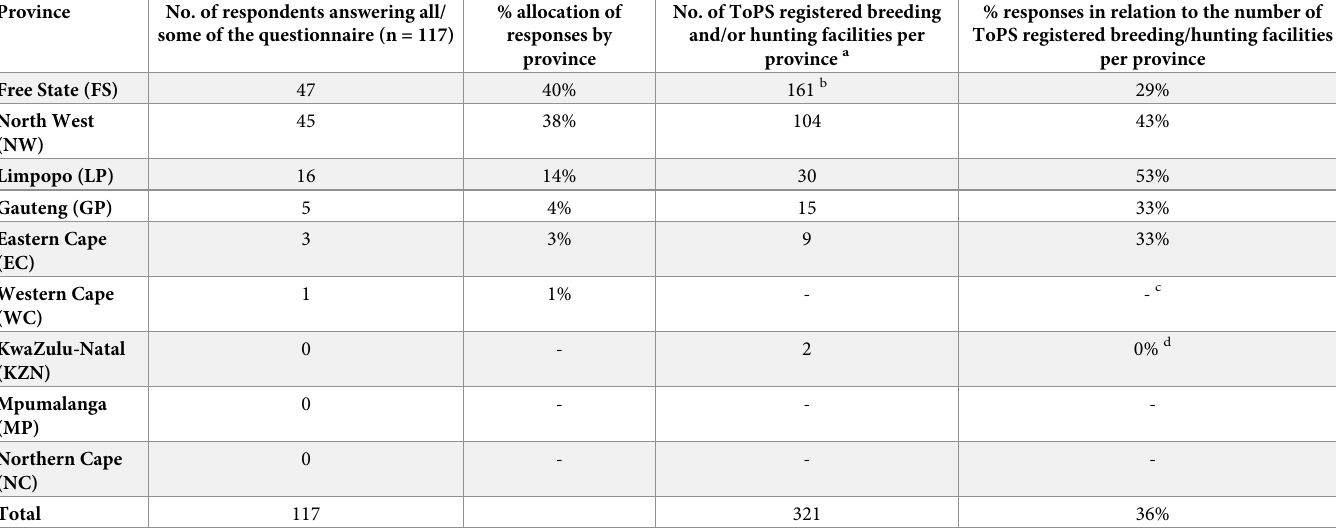
Table 1. Number and proportion of survey respondents by province and in relation to the total number of registered ToPS (Threatened or Protected Species) breed- ing and hunting facilities per province. No. of respondents answering all/ some of the questionnaire (n =